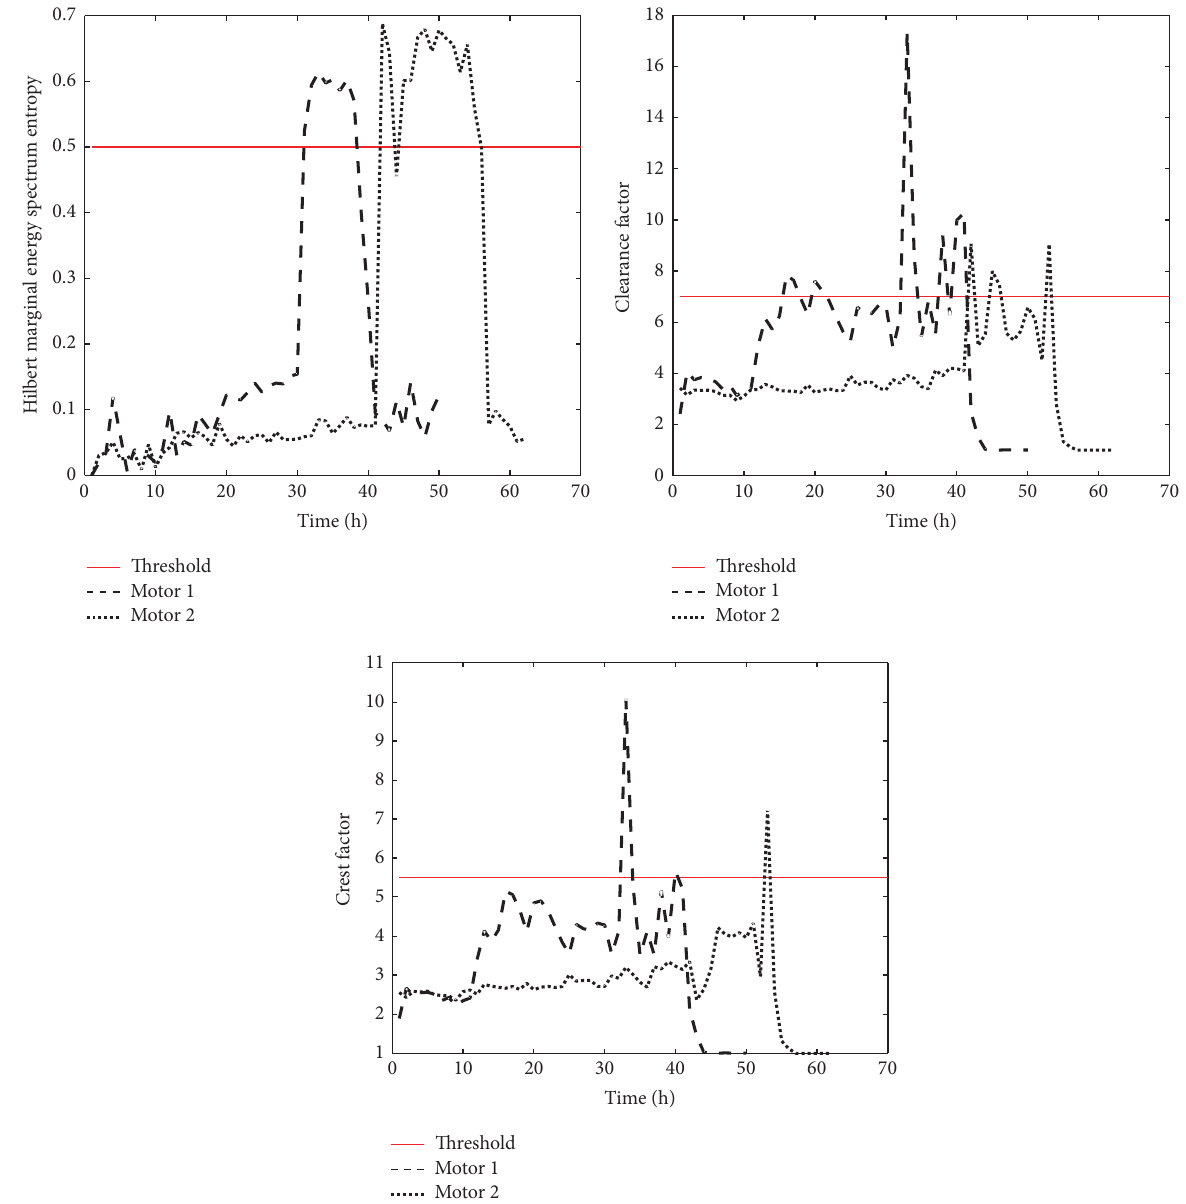
Figure 7: Determination of the failure